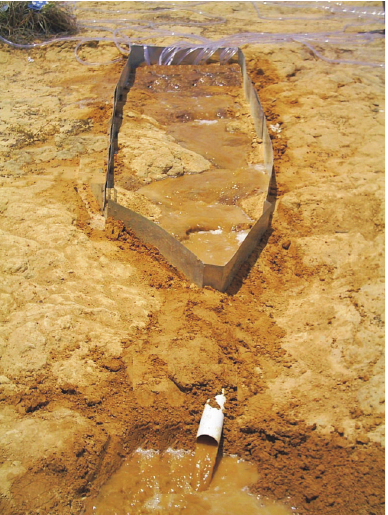
Figura 1. Parcela experimental em ravina com crosta superficial em Latossolo Amarelo distrófico do